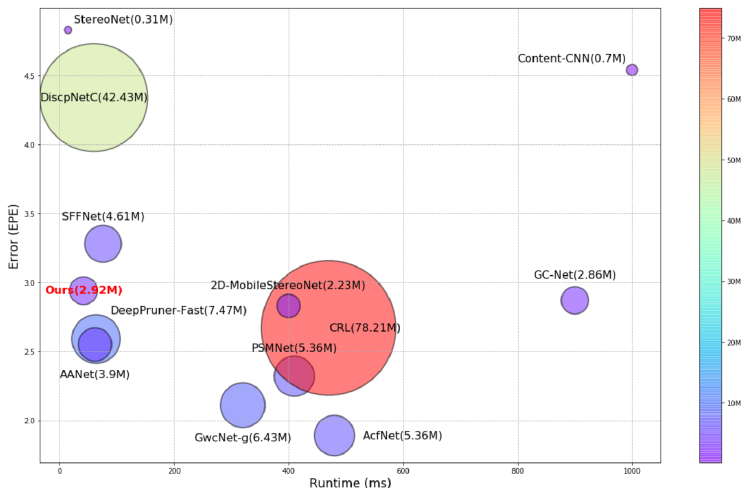
Figure 1. Visualization of runtime, accuracy, and number of parameters of stereo-matching networks, including Content-CNN [9], GC-Net [11], PSMNet [12], StereoNet [13], GwcNet-g [15], DeepPruner- Fast [26], AANet [16], AcfNet [18], DispNetC [10], CRL [27], SFFNet [17], 2D-MobileStereoNet [28], and our proposed method, on KITTI 2015 leader board